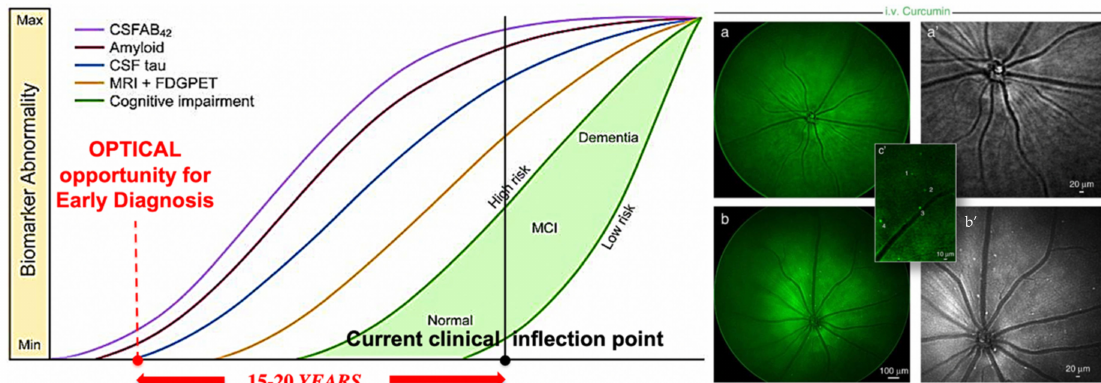
Figure 21. Retinal Optical Imaging: using biomarkers for very early detection of Alzheimer’s Disease. Left (modified from [155]): If a proper AD biomarker is identified and is assessable (via high-resolution imaging) when it is significantly smaller than the current detection limit by any other method, insights could be gained on early pathology that precedes disease symptoms by as much as 20 years, thus opening new interventional possibilities; Right: representative imaging data in living mice retinas, showing no plaques (( a , a’ ), top) and early plaques (( b , b’ ), bottom) at higher resolution (( c’ ), insert), all highlighted by fluorescence of (intravenously injected) curcumin